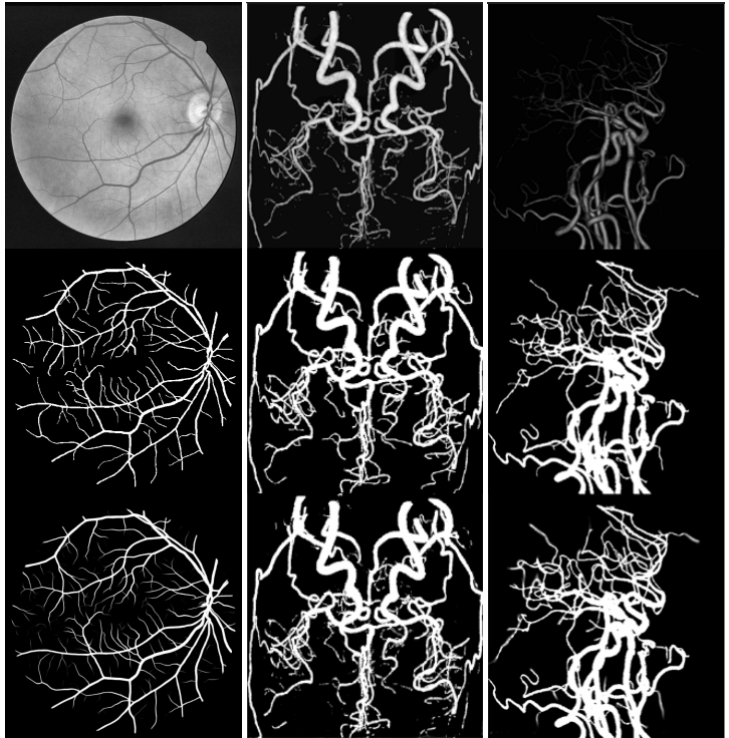
Figure 5. Complex vessel segmentation results. From left to right are the DRIVE, CORO, and ELE